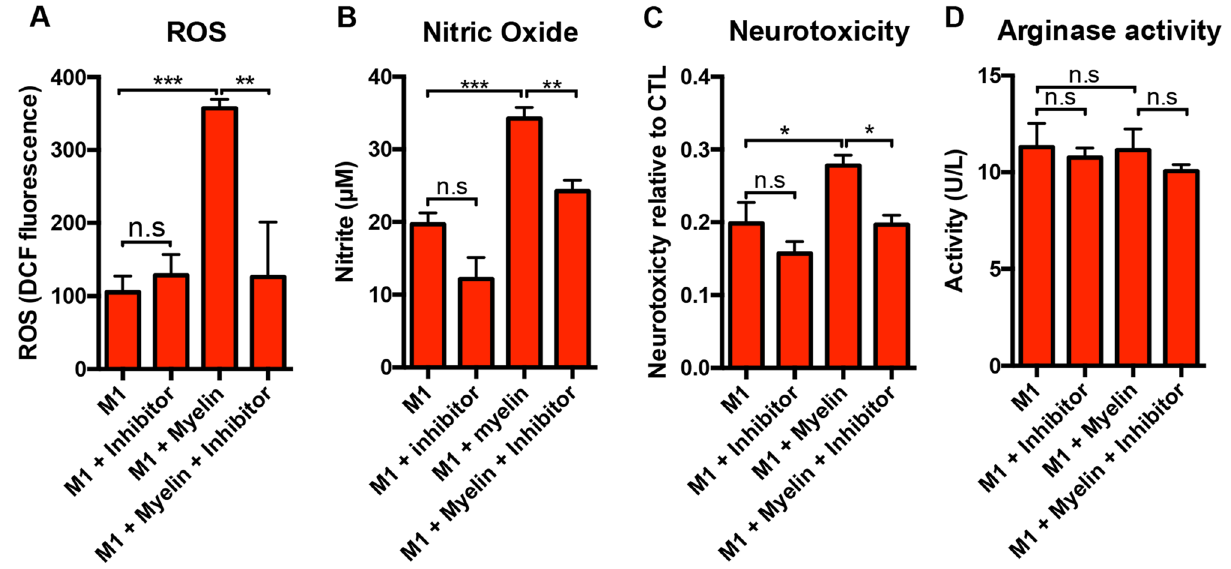
Figure 3. Inhibition of cPLA 2 with PACOCF3 reduces the pro-inflammatory effects of myelin on M1 macrophages. BMDMs were grown and stimulated as in Fig. 2, with or without the addition of cPLA 2 inhibitor, PACOCF3 (50 µM). ( A ) cPLA 2 inhibition reduced myelin mediated ROS increases in M1 (IFN-γ and LPS) macrophages. ( B ) cPLA 2 inhibition reduced myelin mediated nitric oxide production. ( C ) cPLA 2 inhibition reduced the neurotoxic potential of M1 macrophages treated with myelin as determined by an MTT assay measurement of N2a cell viability. ( D ) cPLA 2 inhibition did not significantly alter arginase activity. Representative of 3 biological replications of both BMDMs and myelin source. *p < 0.05, **p < 0.01, ***p < 0.001 mean ±